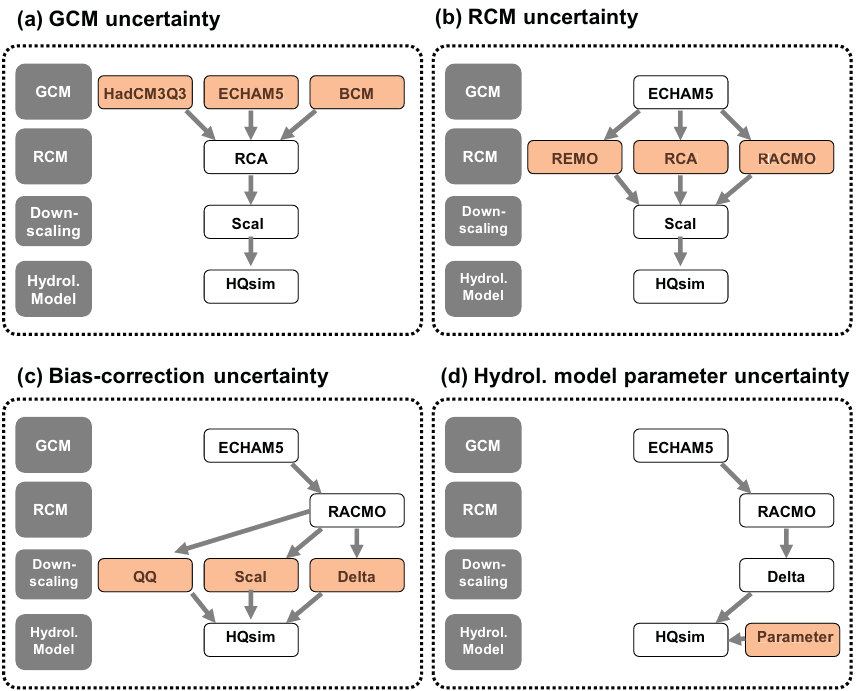
Fig. 2. Modelling chains used to assess (a) GCM uncertainty, (b) RCM uncertainty, (c) bias-correction uncertainty and (d) hydrological model parameter